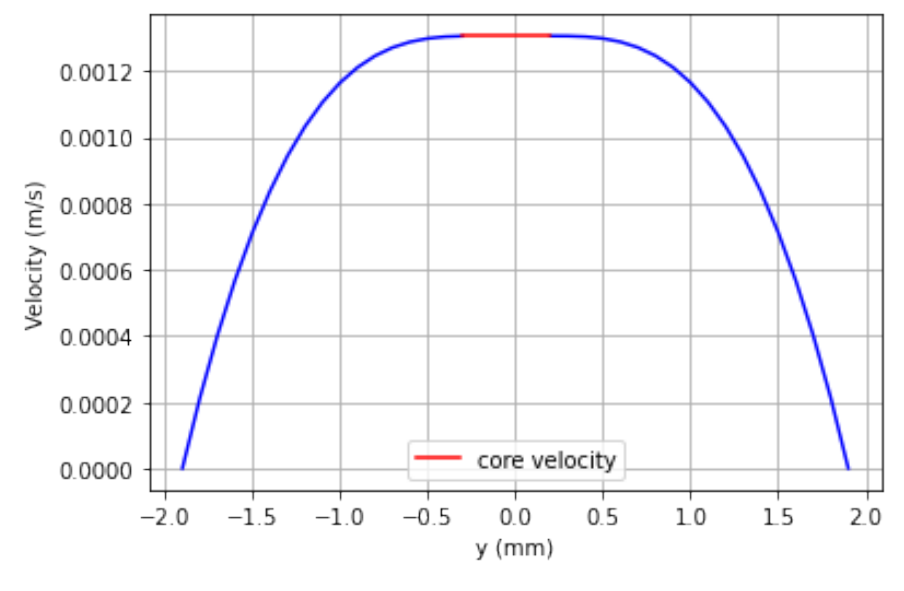
Figure 2. Velocity profile of Casson